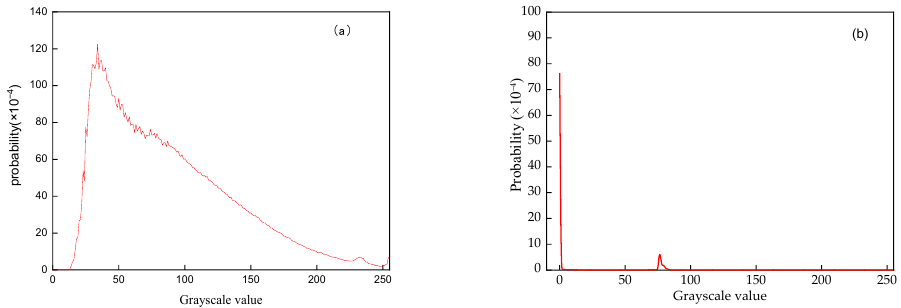
Figure 6. Pore images of the filter cake solidified with epoxy resin and red colorants and their grayscale value distribution. ( a ) Epoxy resin and yellow colorant; ( b ) epoxy resin and red colorant).